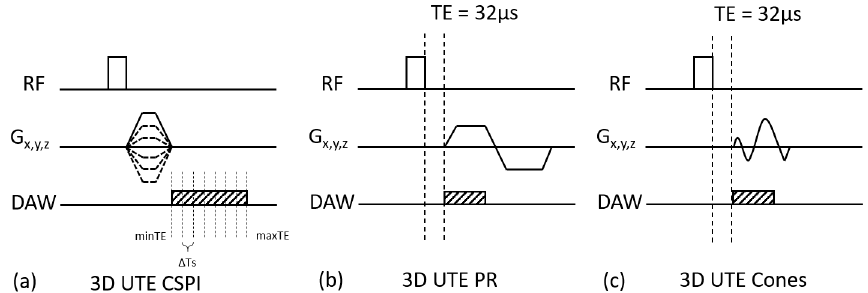
Figure 1. Three different sequences for the comparative ultrashort echo time quantitative susceptibility mapping (UTE-QSM) studies: ( a ) the 3D UTE continuous single point imaging (CSPI) sequence with a minimum echo time (minTE) of 528 µ s, ( b ) the 3D UTE projection reconstruction (PR) (radial) sequence with a minimum TE of 32 µ s, ( c ) the 3D UTE Cones sequence with a minimum TE of 32 µ s. (RF means Radio Frequency pulse, DAW means Data Acquisition Window).